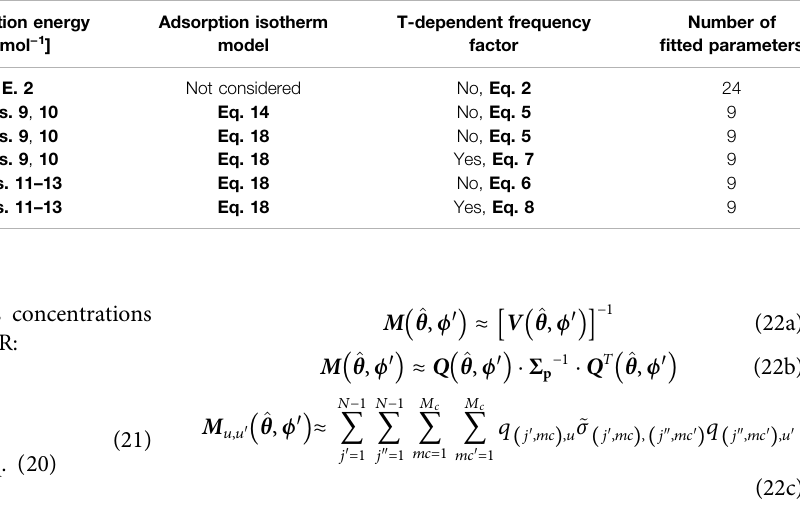
TABLE 1 | Kinetic model library. M0 is the Arrhenius-form simple model with constant frequency factor and activation energy parameters (no correlations). M1 is the ROK model adopted from Oliveira et al. (2010). In M2 and M3 , the adsorption enthalpy and adsorption isotherm models are updated. Unlike M2 , M3 has a temperature- dependent frequency factor. In addition to the changes in M2 and M3 , M4 and M5 have activation energies updated to match the MK model. Similar to M3 , M5 has a temperature-dependent frequency factor while M4 does